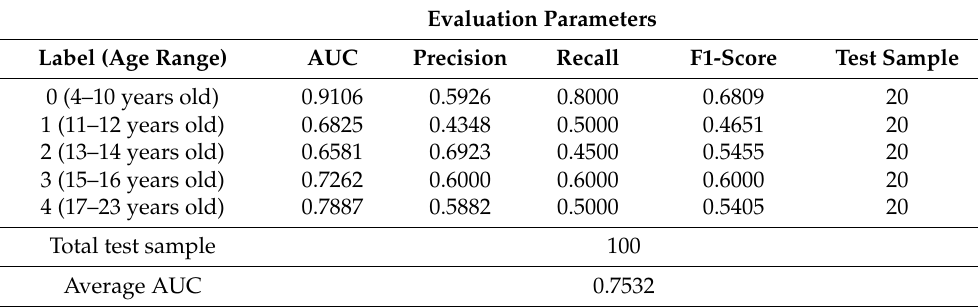
Figure 14. The confusion matrix of age range prediction model by midpalatal suture image features verified in the test set. Table 5. Evaluation of age range prediction model by midpalatal suture image